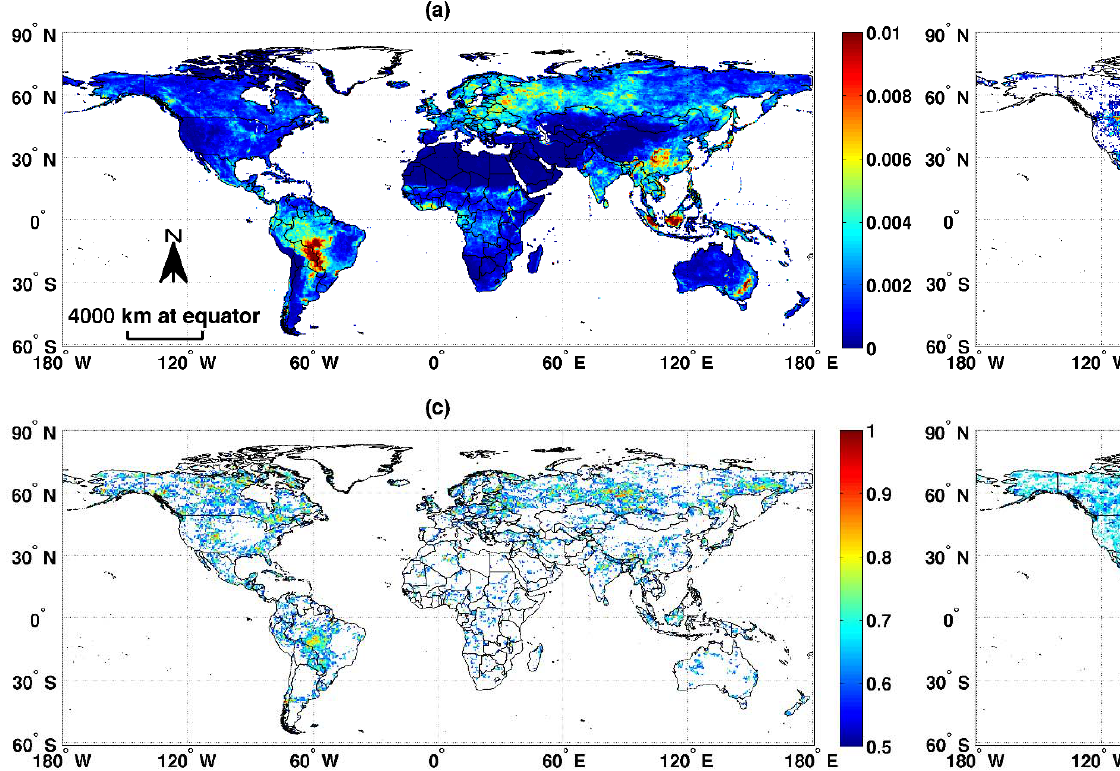
Figure 10. Maps of ( a ) September GIMMS NDVI variance (1982–2010), ( b ) the fraction of September NDVI variance explained by climate (same as Figure 9g), ( c ) the fraction of September NDVI variance induced by current monthly precipitation, snow, aerosols and clouds (all negatively correlated with NDVI), and ( d ) the fraction of September NDVI variance not explained by either climate in (b) or the interfering elements in (c). For (d), white color on land represents no significant correlation between NDVI and any of the climatic variables or interfering elements and the fraction of unexplained variance is set to be 1 (Spatial resolution: